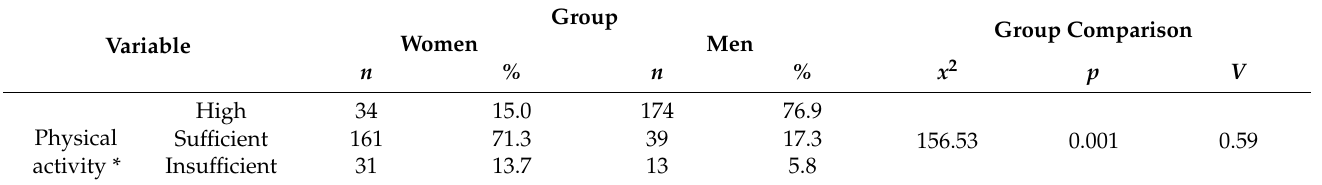
Table 2. Comparison of physical activity levels of women and